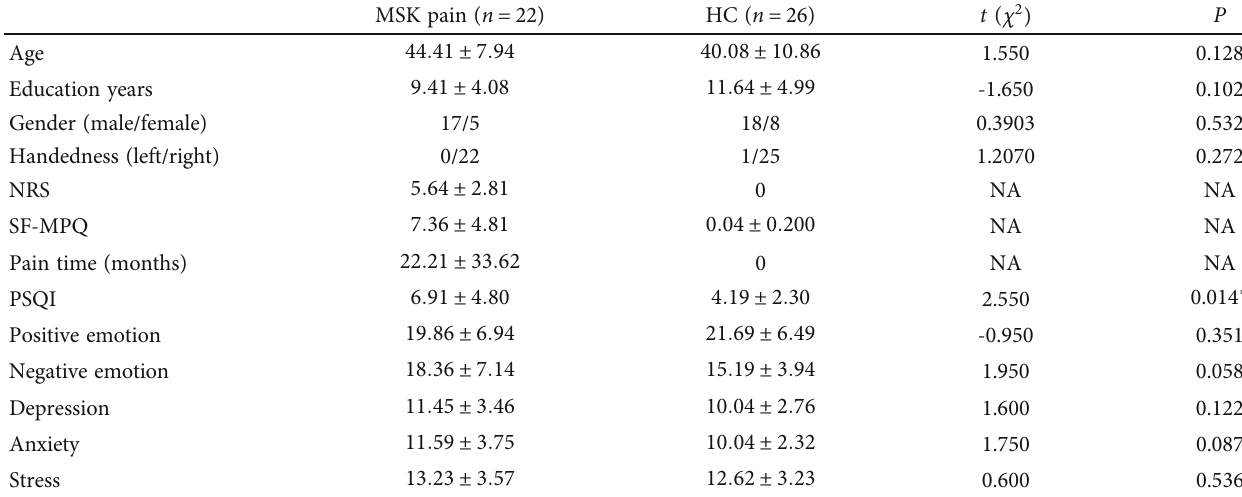
Table 2: Demographic and psychological characteristics of chronic musculoskeletal pain (MSK pain) patients and healthy controls (HCs).